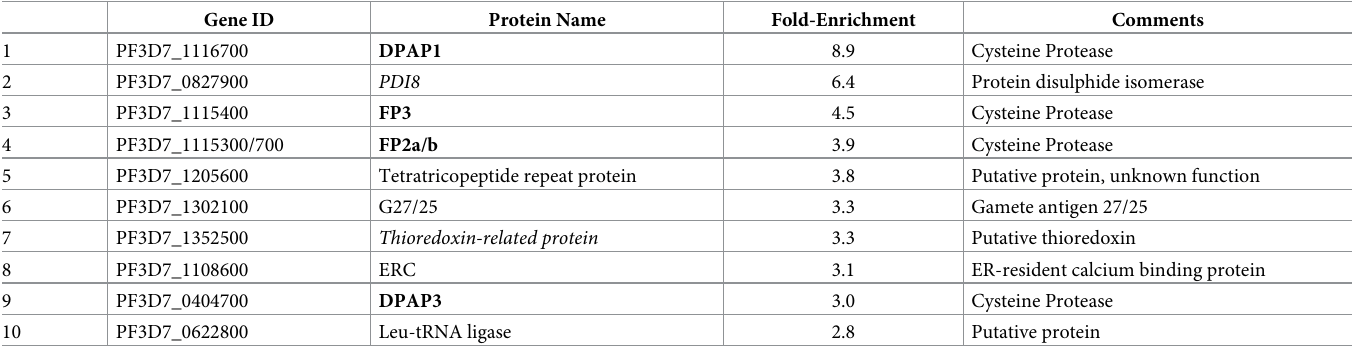
Table 1. Top ten enriched proteins using the W-BF-VS probe.